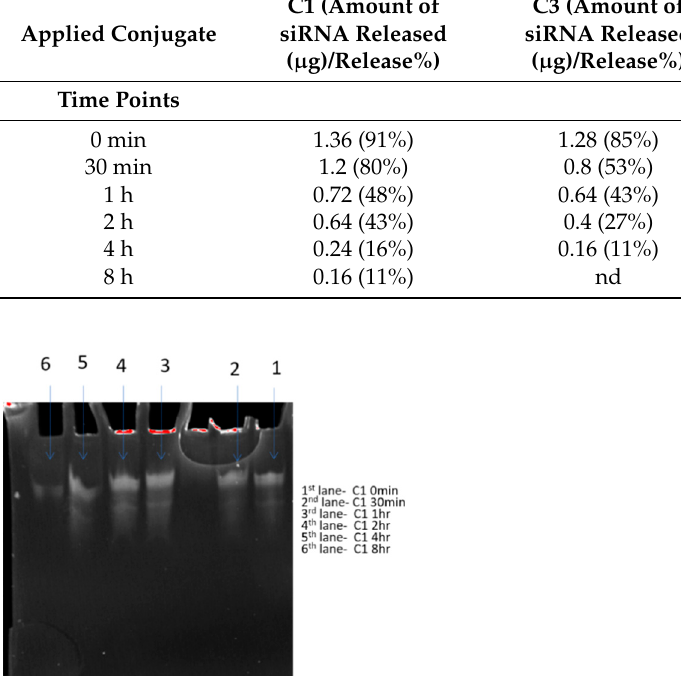
Table 3. Amount of intact siRNA in nanoparticles C1, C3 and control at different time points. nd = not detected. C1 (Amount of Applied Conjugate siRNA Released